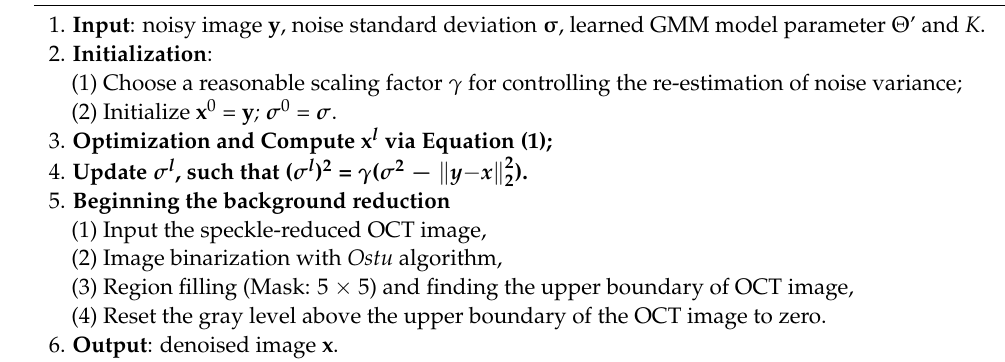
Algorithm 1: Proposed algorithm for denoising of OCT images